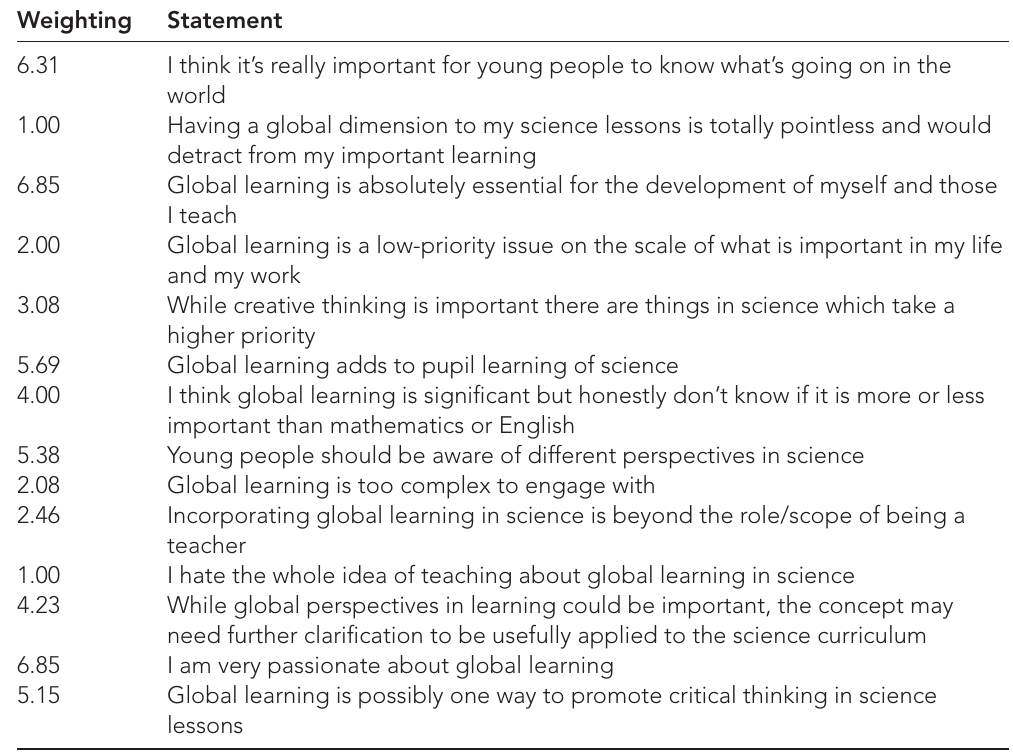
table 2: the attitudinal survey for the Global learning in primary Science project (adapted from bamber et al., 2013)